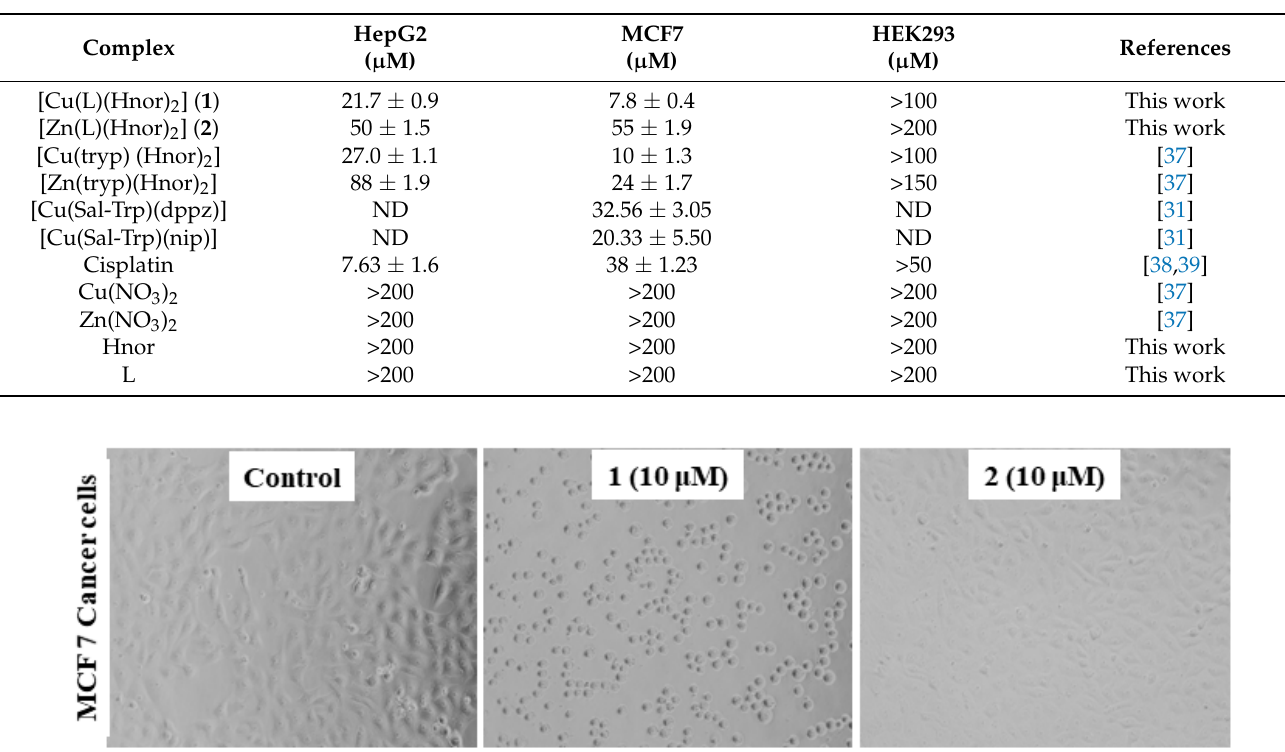
Figure 4. Morphology of the human breast cancer (MCF7) cells, untreated (control) and treated with Cu(II) ( 1 ) and Zn(II) ( 2 ) complexes.